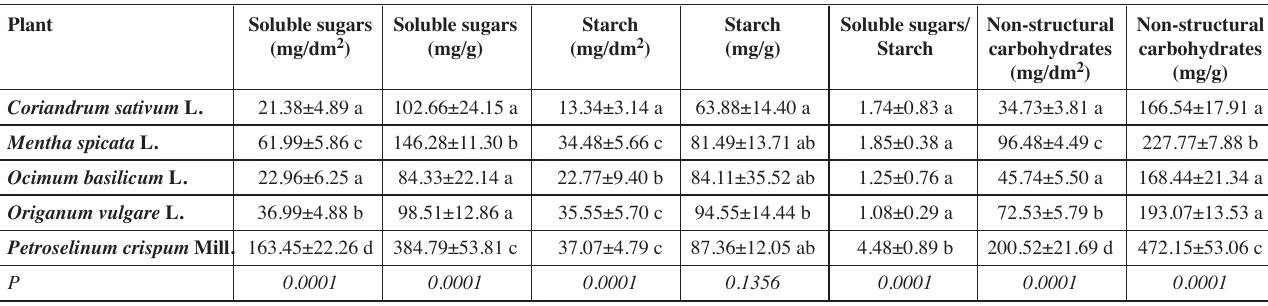
Tab. 3: Soluble sugars, starch and non-structural carbohydrates content (mg/g or mg/dm 2 of fresh weight) of leaves of the five studied species of medicinal and aromatic plants (mean ± SD, n = 6). Plant